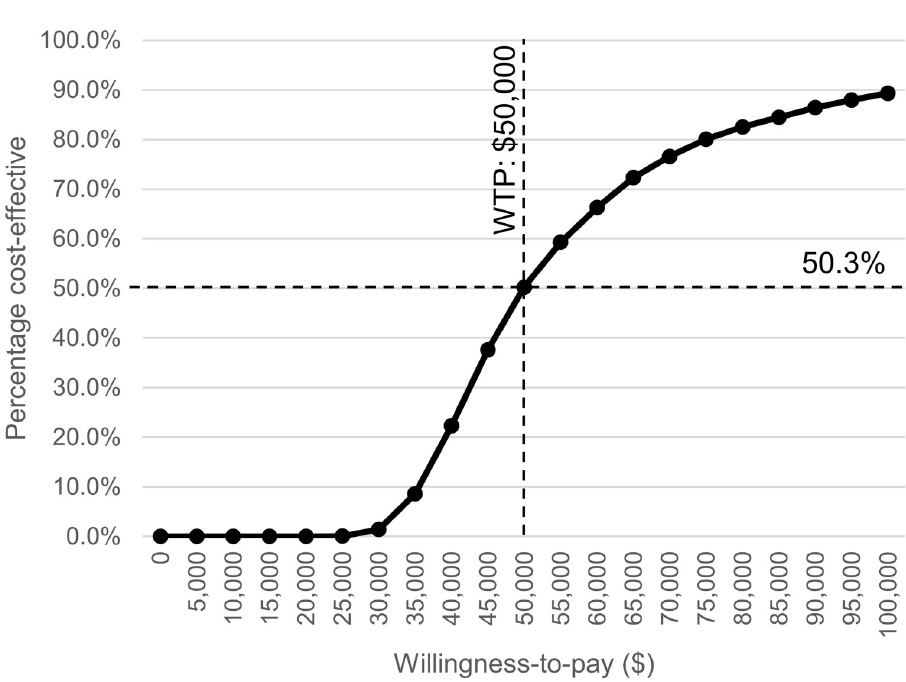
Fig 6. Cost-effectiveness acceptability curves. Willingness-to-pay ($) is shown with percent cost-effectiveness. The dashed line is a willingness-to-pay threshold (WTP) of $50,000/QALY and the percent cost effectiveness is 50.3% at a WTP of $50,000/QALY. Abbreviations. WTP,